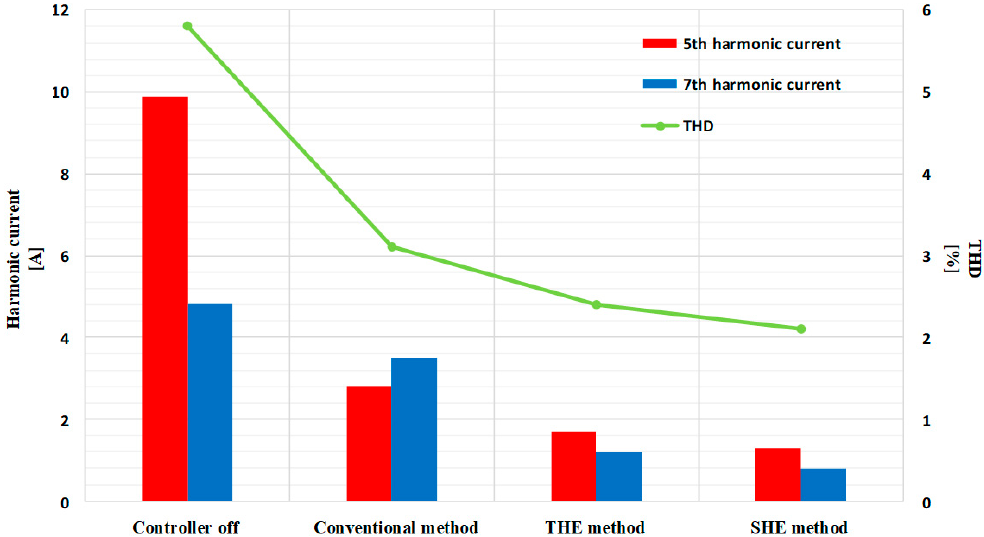
Figure 25. Experimental results analysis of output currents based on harmonic compensation method.